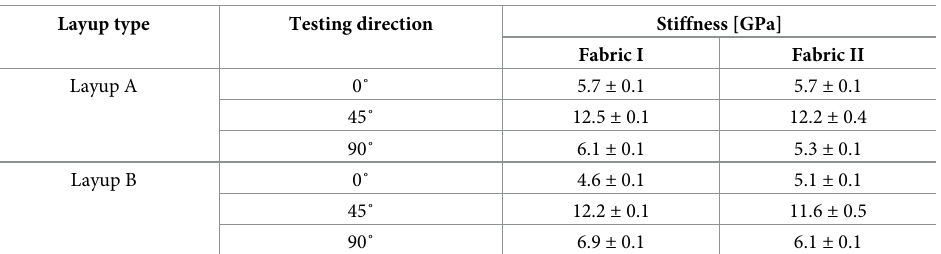
Table 4. Measured stiffness of the multiaxial flax fibre composite